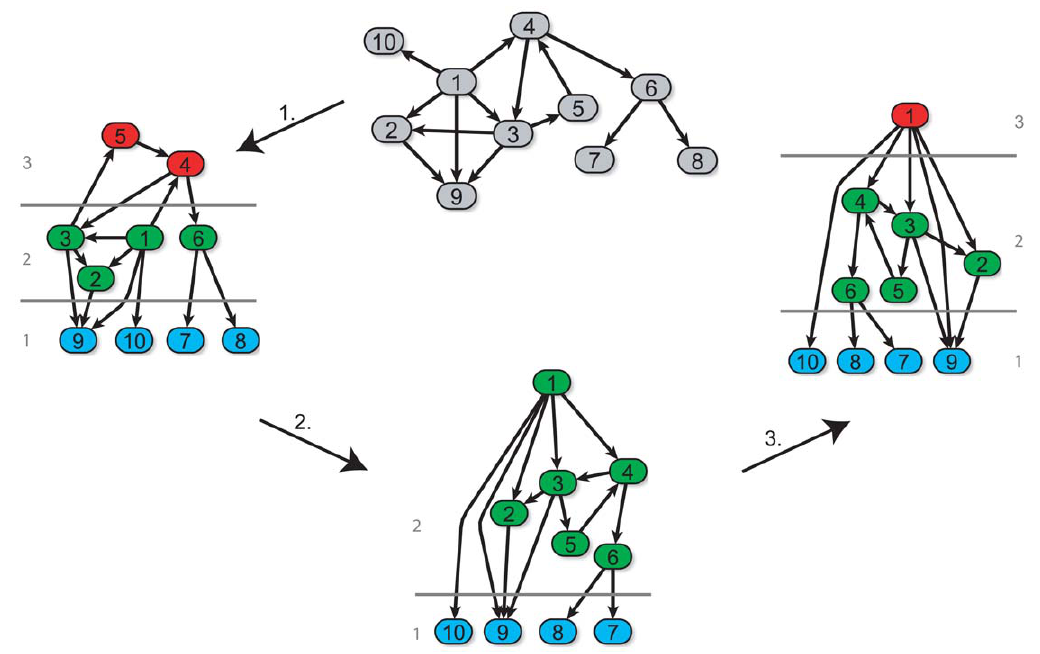
Figure 2. Illustration of the hierarchy extraction approach. We illustrate the approach of hierarchy extraction from directed networks. In the first step, the original network (grey) is traversed into a shortest path-tree (step1) with an initial hierarchical organization consisting of three layers. As this alone does not capture all feasible solutions we introduce two correction steps to resolve conflicts in the level assignments (e.g. node 1 is located in level 2, but it is regulating node 4 that is located in level 3). First, in the ‘‘downgrade’’ step each vertex is placed on the lowest level that this vertex and its regulating vertices are assigned to (step2). Thereby it is assured that each regulator has at least the same level assignment as its targets. Here, node 4 and node 5 are downgraded from level 3 to level 2 as its regulators - node 1 and node 3- are assigned to level 2. Second, vertices are ‘‘upgraded’’ if they have successors with the same level assignment and have no regulators themselves. Here, node 1 has no predecessor and targets on the same level (level 2). Consequently it is upgraded from level 2 to level 3 (step3). In the end HiNO determined a three layered hierarchical structure of the directed network without conflicts in the level assignment. doi:10.1371/journal.pone.0013698.g002 PLoS ONE |